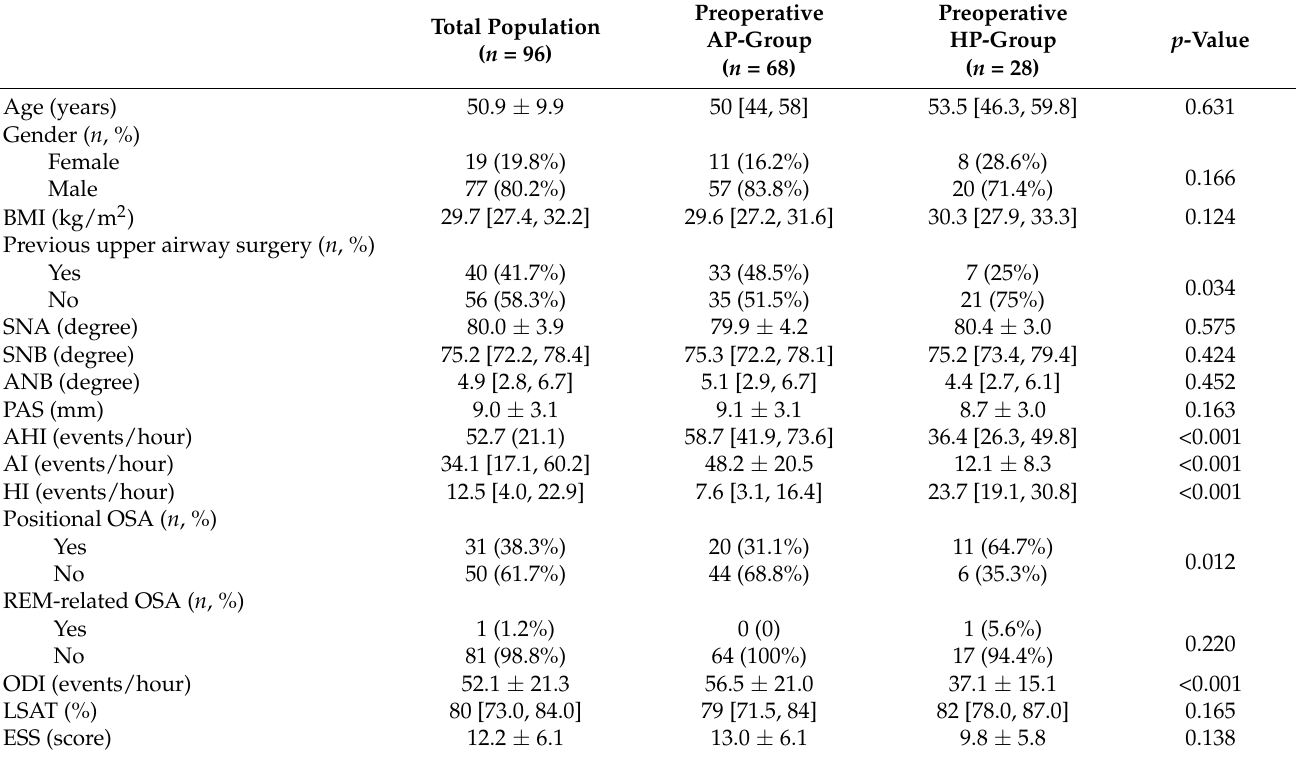
Table 1. Baseline characteristics of the total population, AP-group and